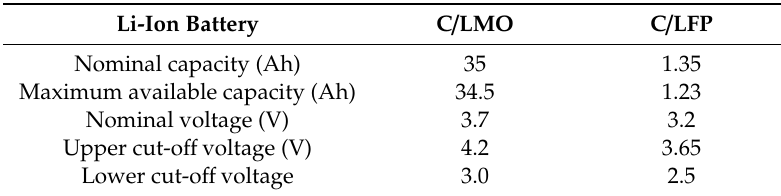
Table 1. Comparison of Li-ion battery specification.